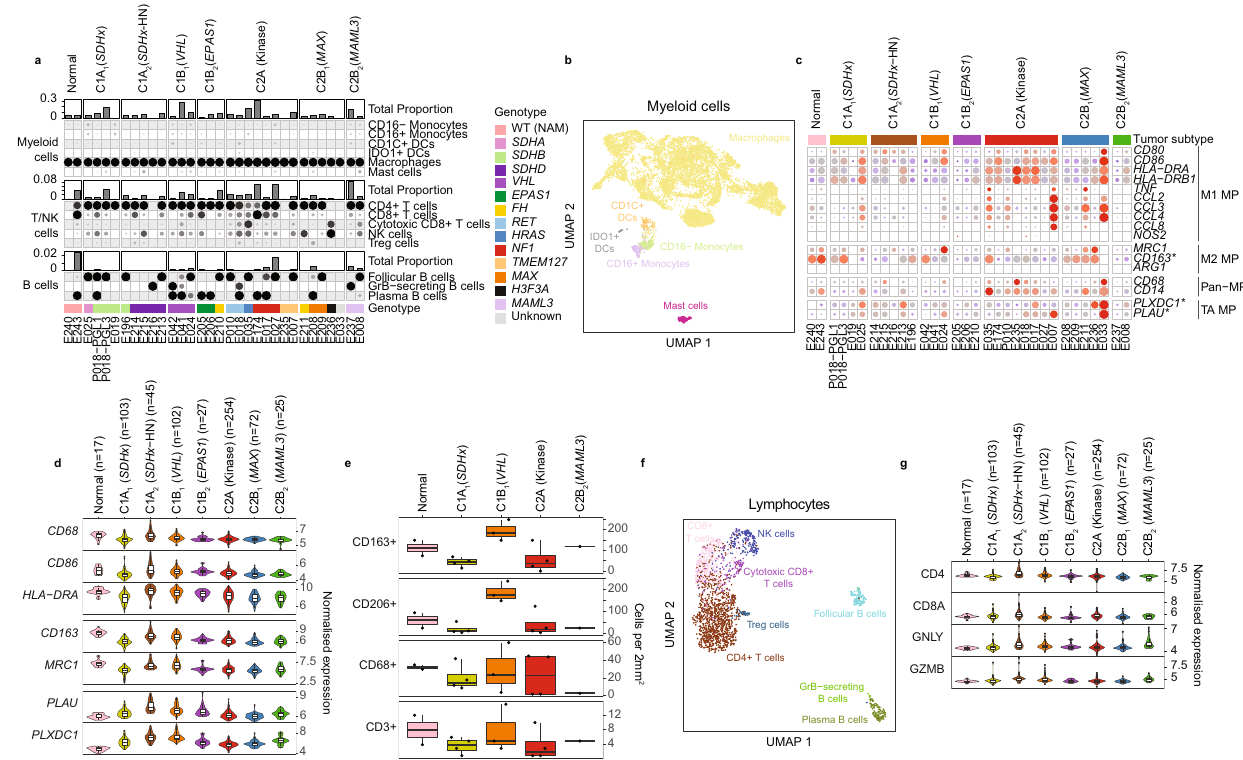
Fig. 4 | Analysis of leukocytes isolated from PCPG and NAM tissues by snRNA- seq. a Supervised classi fi cation of immune cell fractions in PCPG. Proportions of each major immune cell types within each sample (top panel) and the functional subsets that make up each major cell type (bottom panels). b UMAP re-clustering of myeloidcells from all snRNA-seq samples. Nucleiare colored according to their classi fi ed functional cell subsets (nCells=7977). c snRNA-seq expression of mac- rophage (MP) marker genes in macrophages detected on PCPG and NAM tis- sues. (TA: Tumor-associated) d Enumeration of intra-tumoral leucocytes detected by immunohistochemistry staining for canonical macrophage markers (CD163, CD206, CD68) and a T cell marker (CD3) (nSamples = 645, the lower and upper hingesofeachboxplotcorrespondtothe fi rstandthirdquartiles,respectively,and